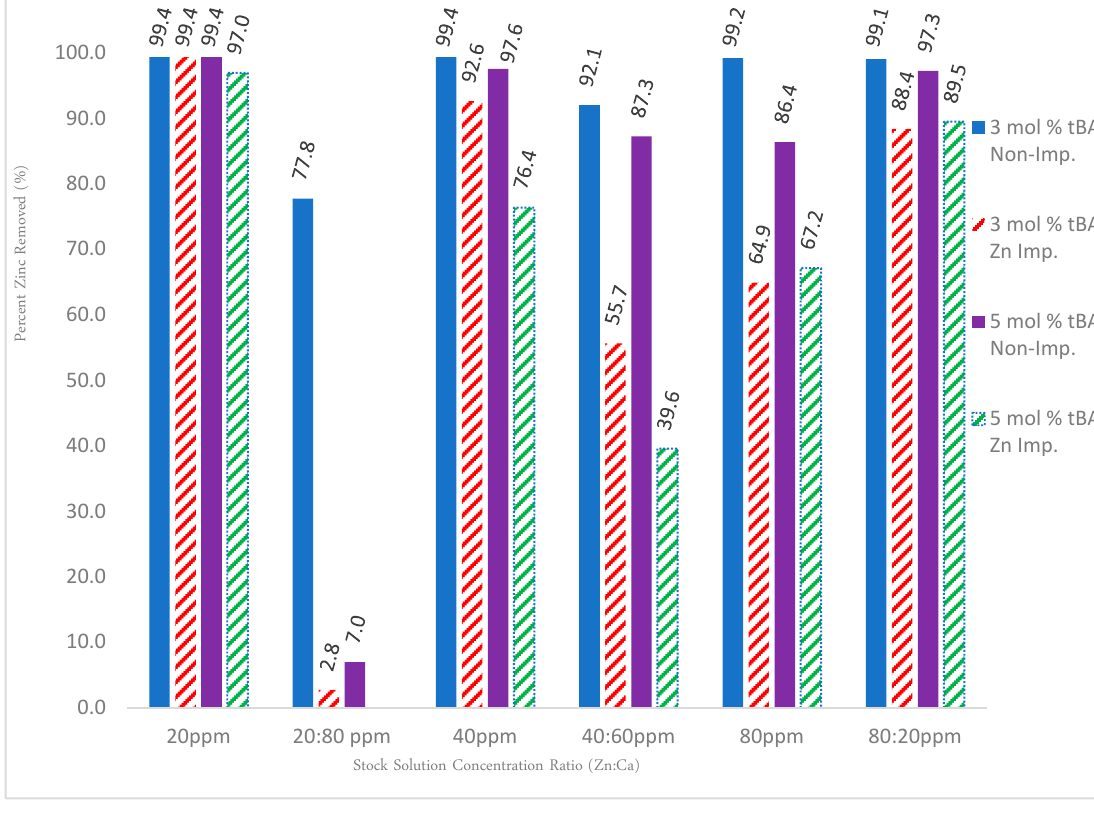
Figure 12. Gravity column results for both unary and binary ion studies for 3% and 5% tBA, both imprinted and non-imprinted. Removal percentages are edited to reflect the rate of removal for zinc for the binary ion studies. All polymers contain 5 mol % EGDA crosslinker.